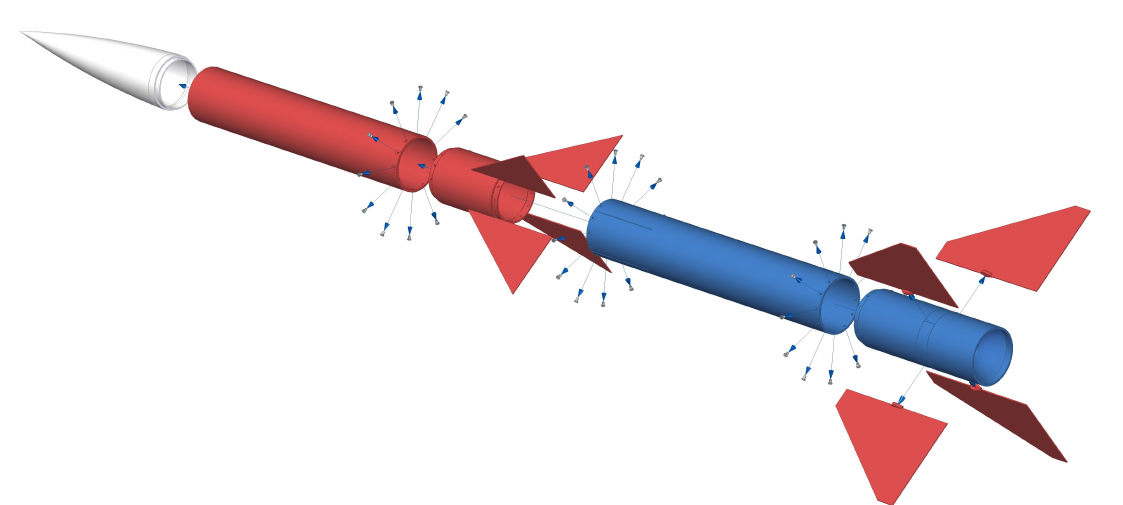
Figure 12. Proposed new AMRAAM airframe system